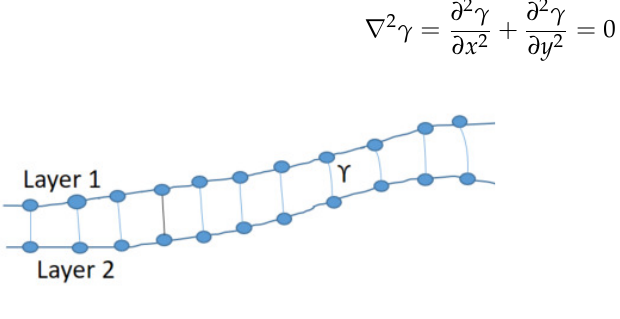
Figure 5. Estimation of the thickness between each of the two layers of the retina.